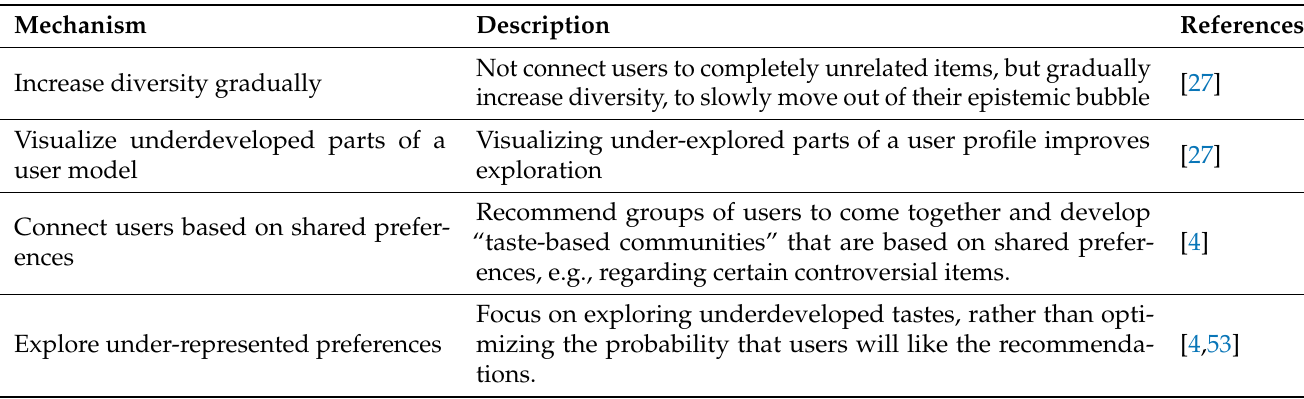
Table 2. Mechanisms to achieve self-actualization